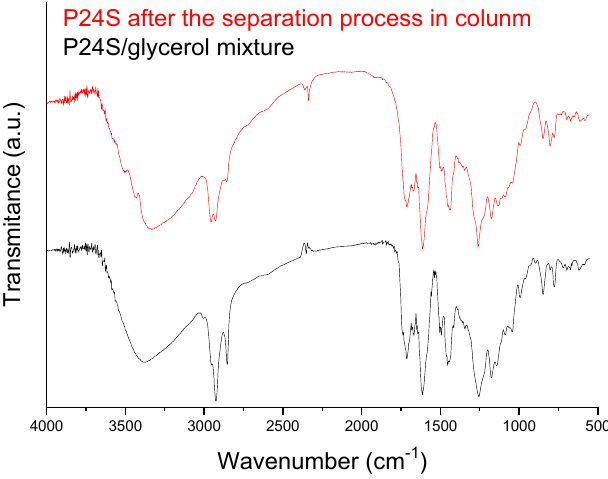
Figure 11. FTIR spectra before and after Oligocat P24 purification.